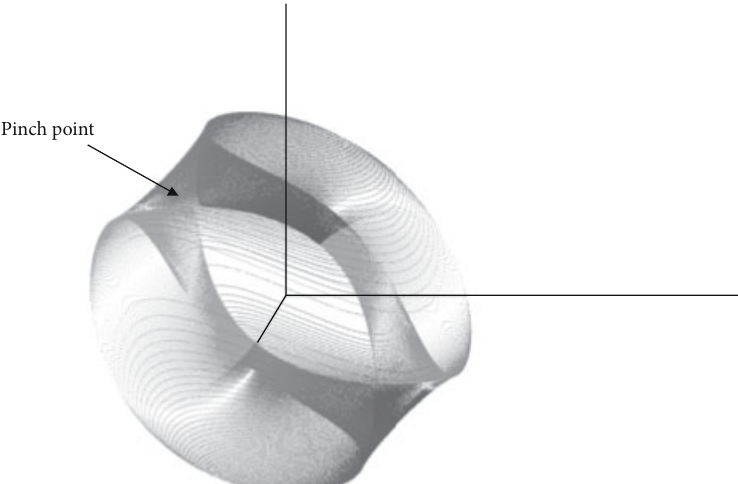
Figure 13: The wave front at t = 7 : 95 in the Type D metric. We see that the wave front develops a pair of pinch points. When these portions of the wave front come together, openings appear and grow, eventually splitting the wave front into the elongated double spear-like structure seen in the last view in Figure 10.